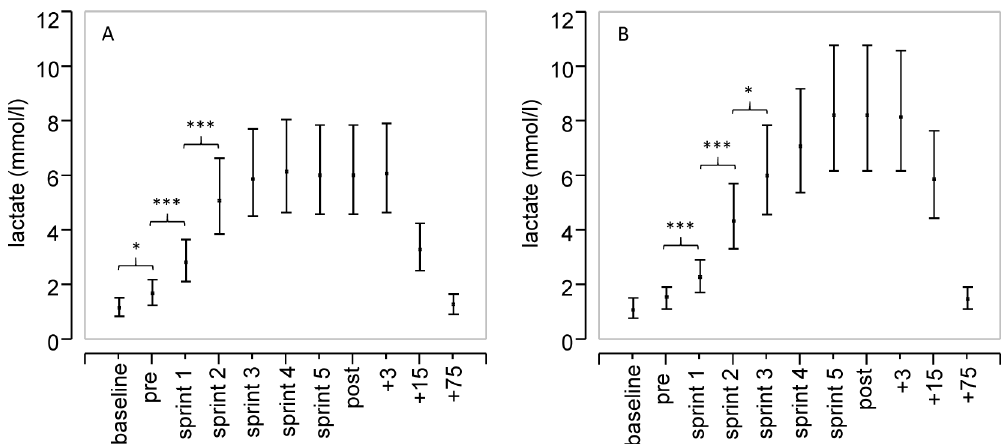
Fig 1. Lactate kinetics during repeated sprint exercise. Concentrations of lactate in athletes before (pre), during (1st– 5th run) and after 3 (+3), 15 (+15) and 75 minutes (+75) of performing five 40 meters sprints with 5 minute pauses (A) and 1 minute pauses (B). Significant difference between both short and long sprint series after the five sprints (p = 0.032). Shown are the mean values and 95% confidence intervals. Significant difference (cid:3) (p < 0.05), (cid:3)(cid:3)(cid:3) (p < 0.001).